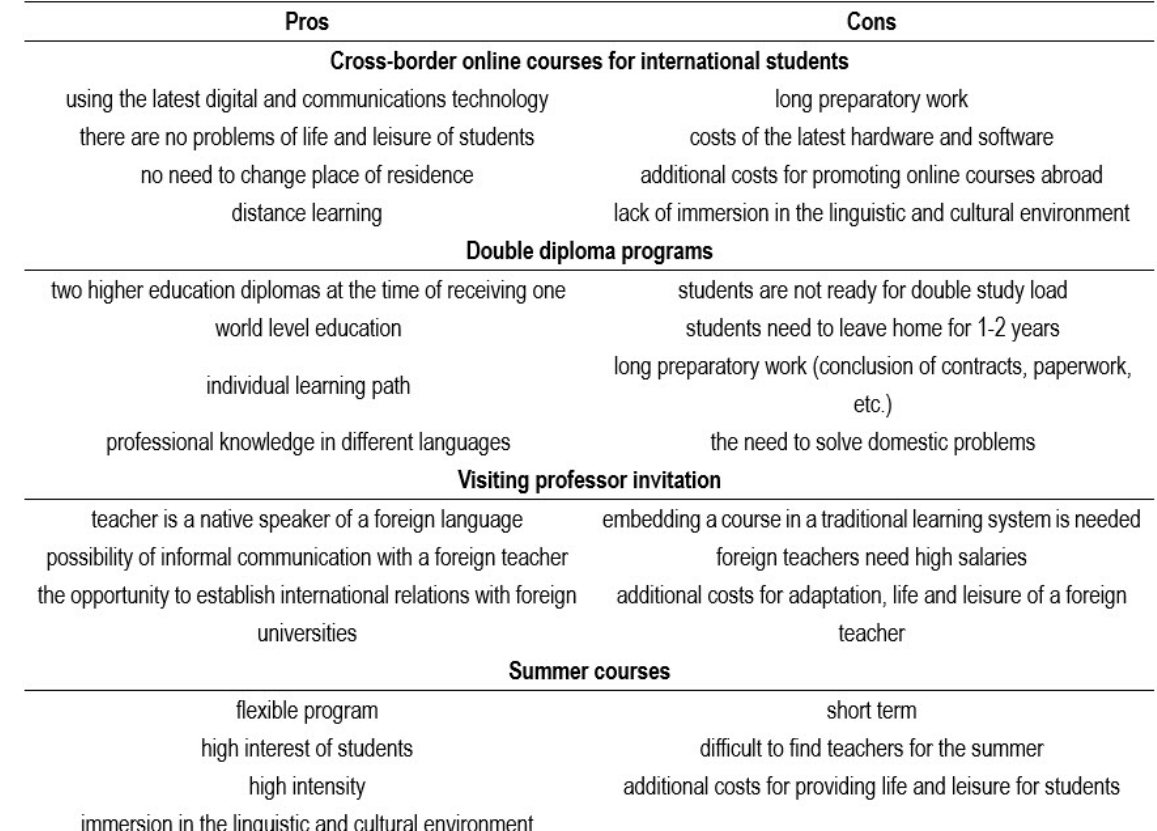
Pros and Cons Analysis of Educational